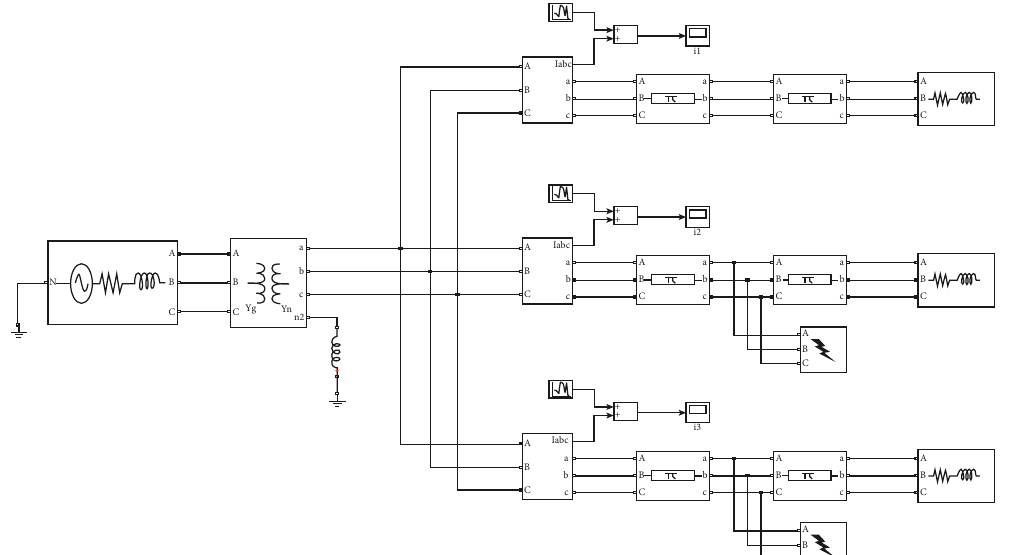
Figure 2: Distribution network simulation